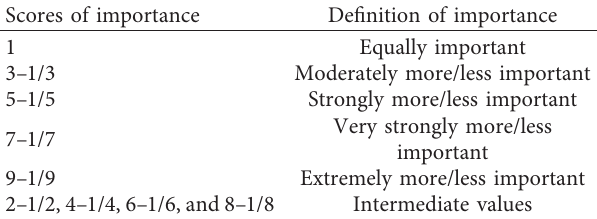
Table 1: Scores of importance scale and its definition [12].